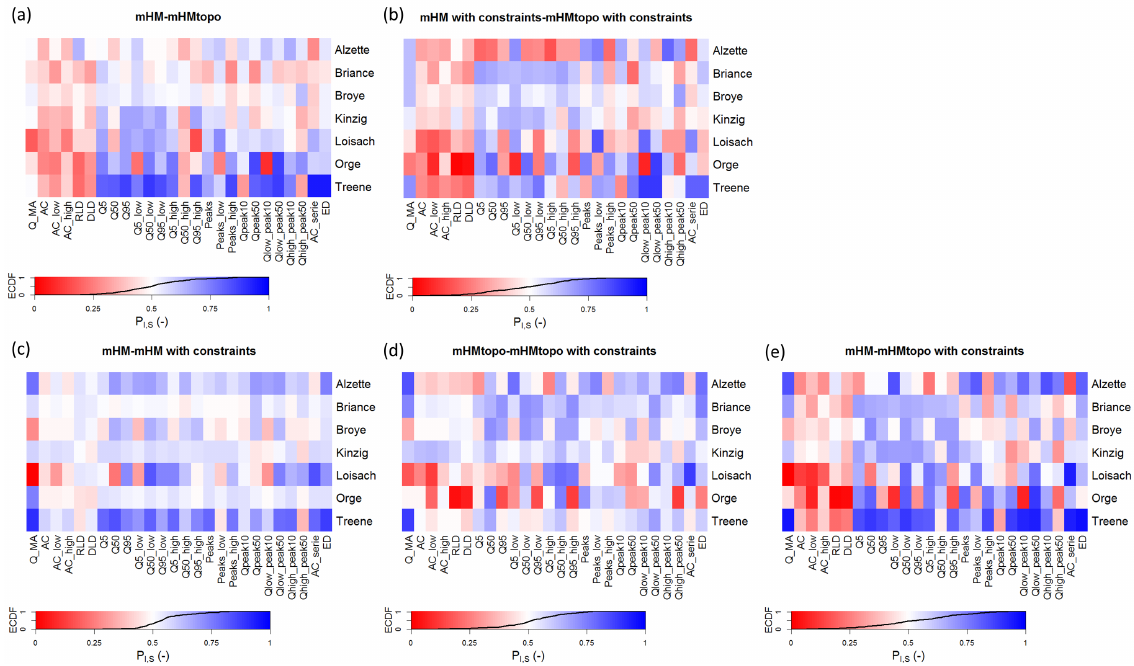
Figure 10. Probabilities of improvements P I , S between (a) mHM and mHMtopo without constraints and (b) with constraints, (c) mHM with and without constraints, (d) mHMtopo with and without constraints and (e) the base case mHM with the constrained mHMtopo case. The colours are linearly related to the probability of improvement between 0 (dark red; e.g. the probability of mHMtopo outperforming mHM is 0), 0.5 (white; i.e. models are statistically equivalent) and 1 (dark blue; e.g. the probability of mHMtopo outperforming mHM is 1). An empirical cumulative distribution function (ECDF) based on all probabilities of improvement has been added to assess the distribution of these